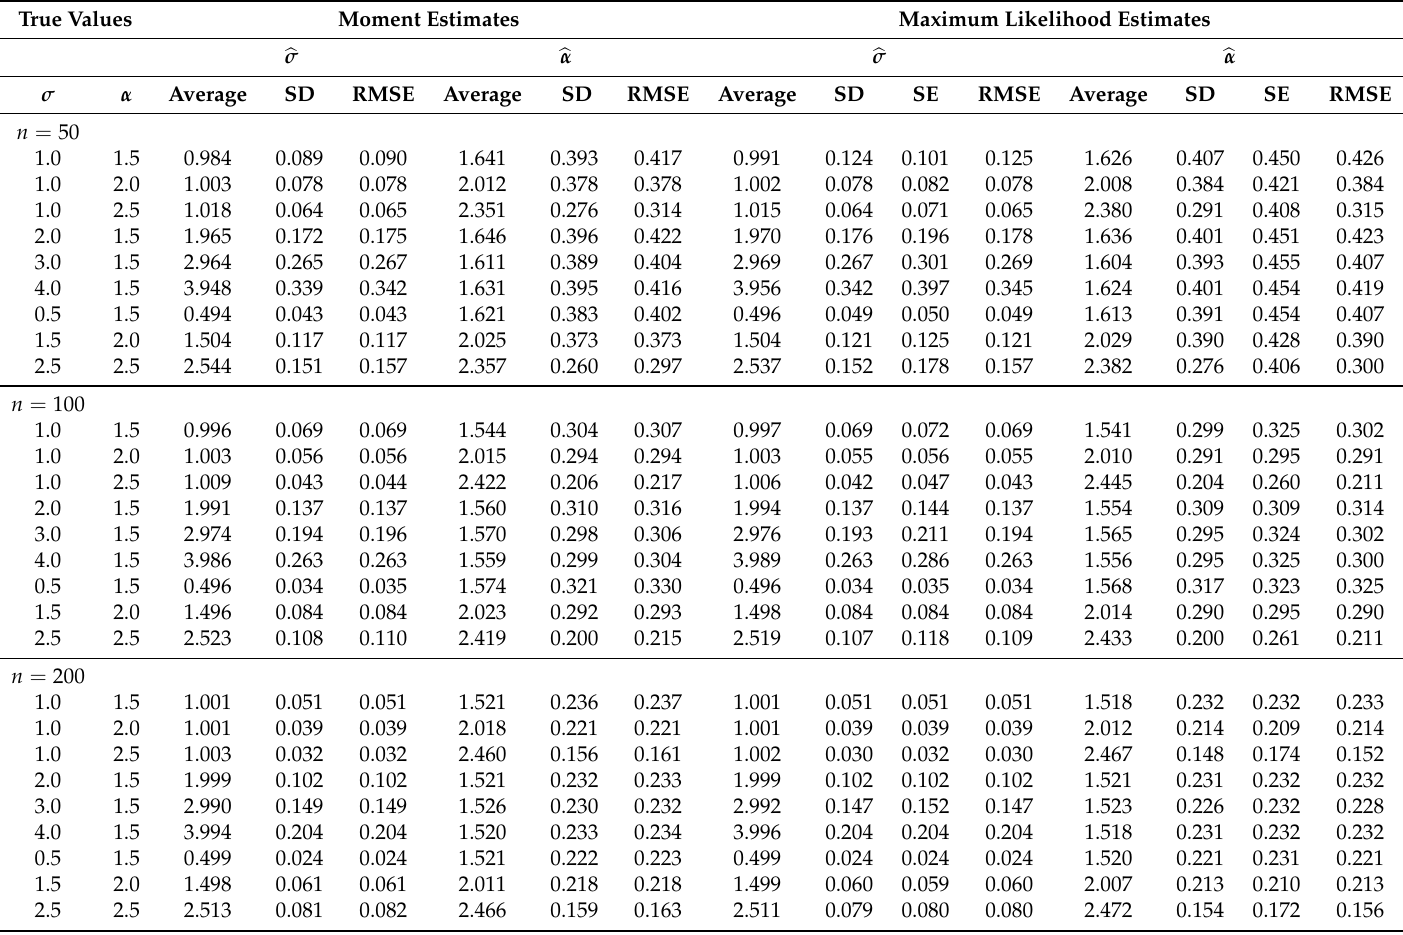
Table 5. Averages, standard deviations (SD), averages of asymptotic standard errors (SE) and roots of the simulated mean square errors (RMSE) for the estimates of σ and α for the LR